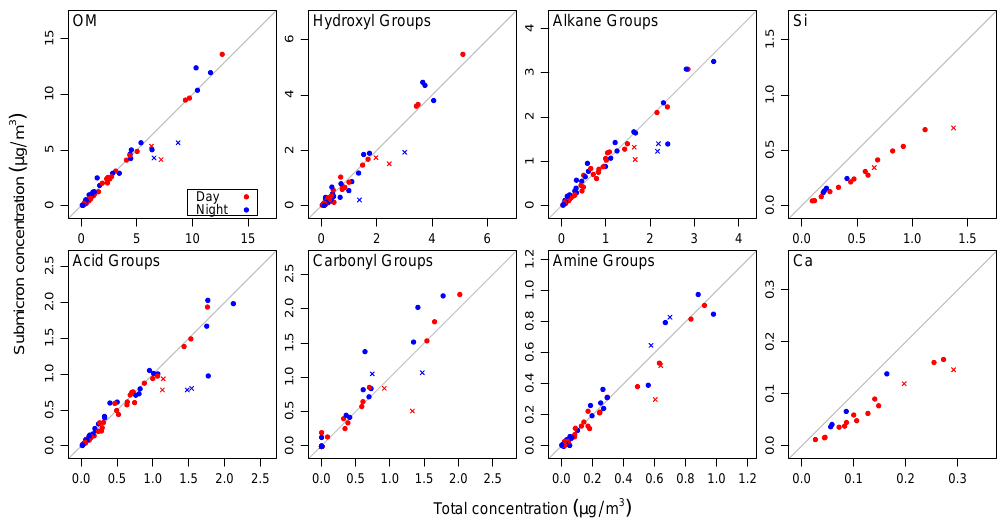
Fig. 4. Comparison between total and submicron sample types for OM, OFGs, and two crustal elements for both day (red) and night (blue) samples. × ’s mark samples with detectable supermicron organic aerosol.